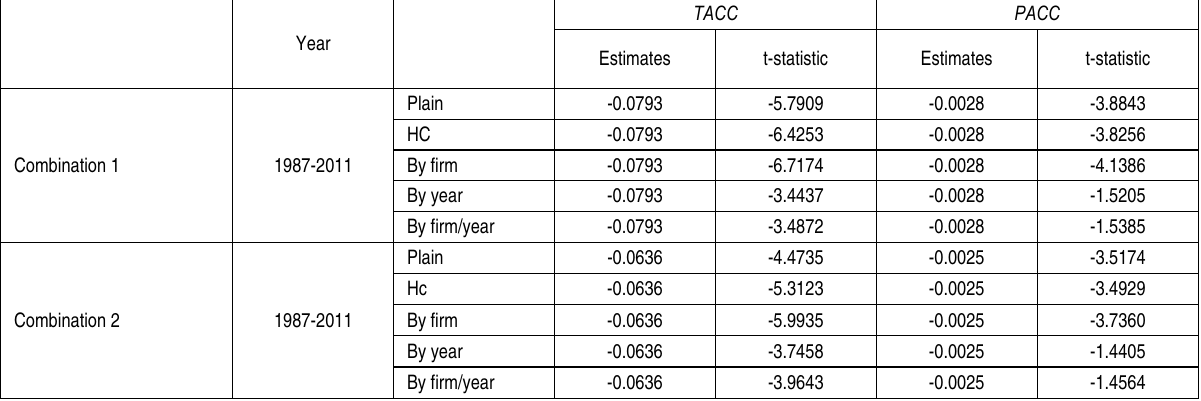
Table 6a. Significance of regression estimates for TACC and